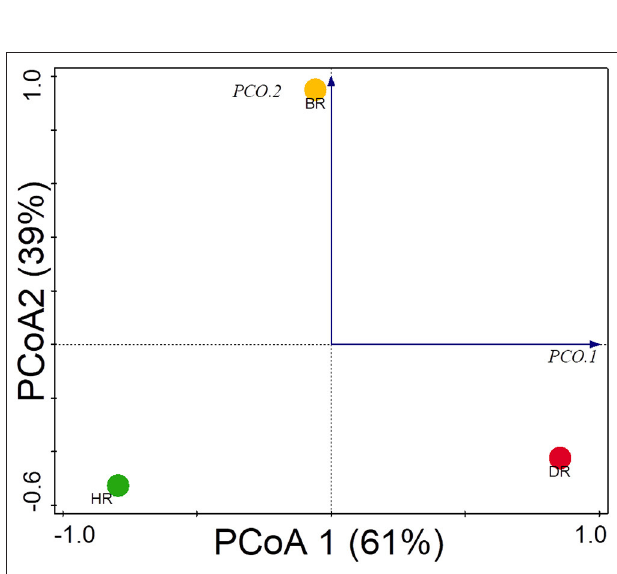
FIGURE 4 | PCoA graph for the functional groups identified at the SEED subsystem Level 1 of rhizosphere microorganisms from each site based on Euclidean dissimilarities. HR, soil obtained from healthy Tomato Rhizosphere; DR, Rhizosphere soil from diseased tomato; BR, Bulk soil.